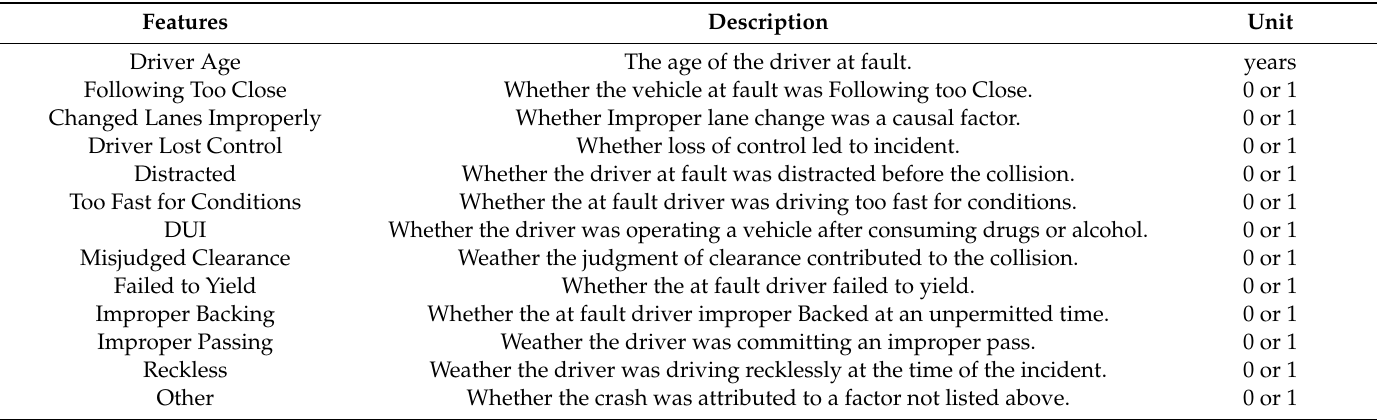
Table 2. Driver-related Feature